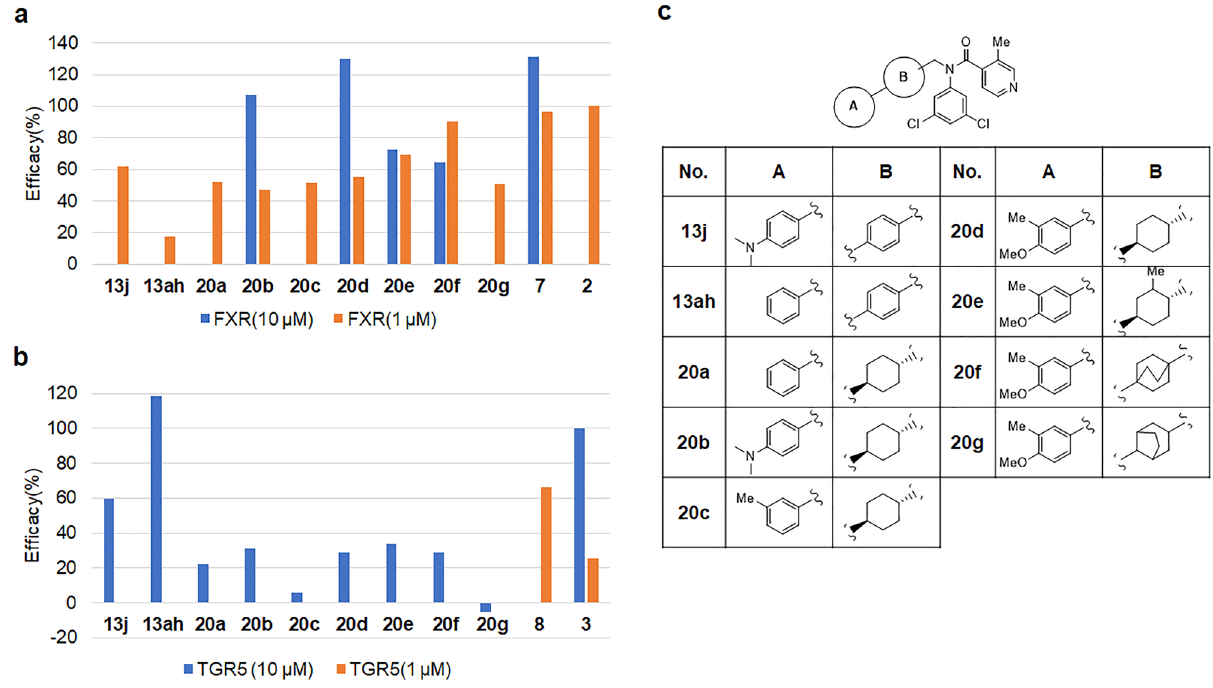
Figure 3. ( a ) FXR agonist activity of isonicotinamide derivatives 13j , 13ah , 20a – 20g . Efficacy(%); % vs OCA 1 µM as 100%, OCA; 100% (1 µM), 13.3% (0.1 µM); ( b ) TGR5 agonist activity of isonicotinamide derivatives